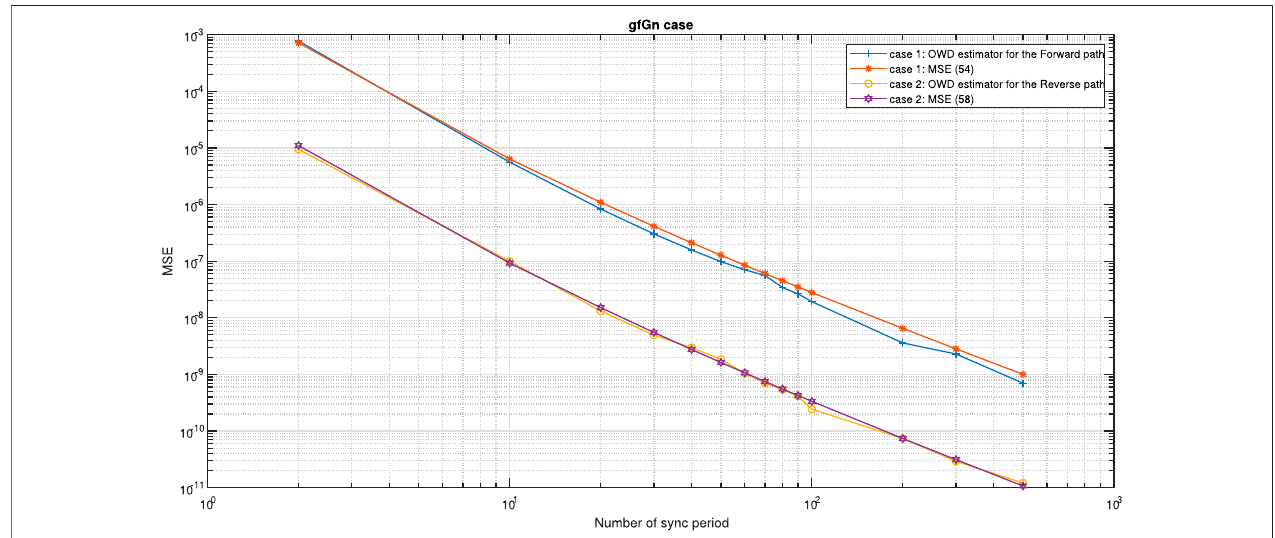
FIGURE 14 | case 1: Performance comparison for the gfGn case, between our new proposed clock skew estimator for the Forward path ( Eq. 61 ) with the performanceresults forournew proposed expression fortheMSE( Eq.54 ). σ ω proposed clock skew estimator for the Reverse path ( Eq. 62 ) with the performance results for our new proposed expression for the MSE ( Eq. 58 ). σ ω For both cases: α = 50 ppm , Q = 5 ms , T syn (cid:2) 15 . 6 ms ( 64 packet